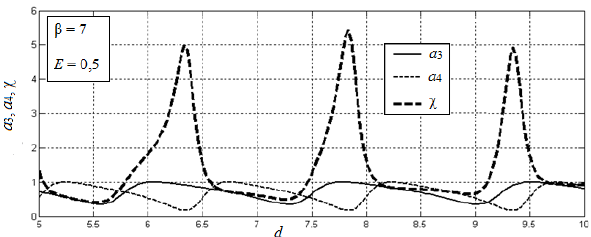
Figure 5: Change in permeability and selectivity with increasing distance between barriers